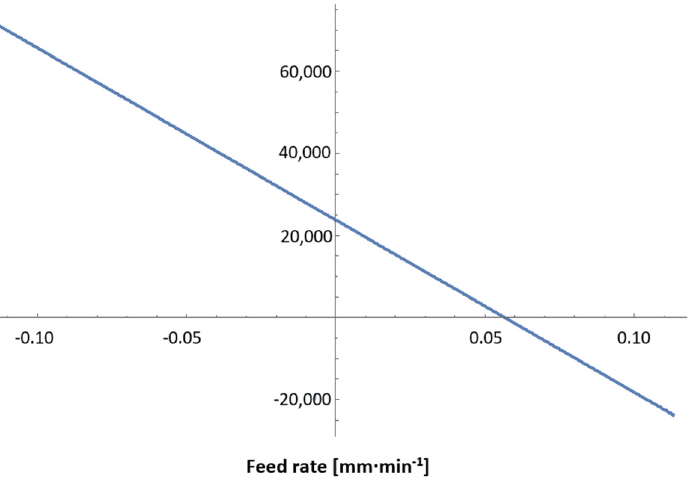
Figure 20. The course of the first derivation of the dependence of the number of holes drilled up to the moment of tool damage and the feed rate.